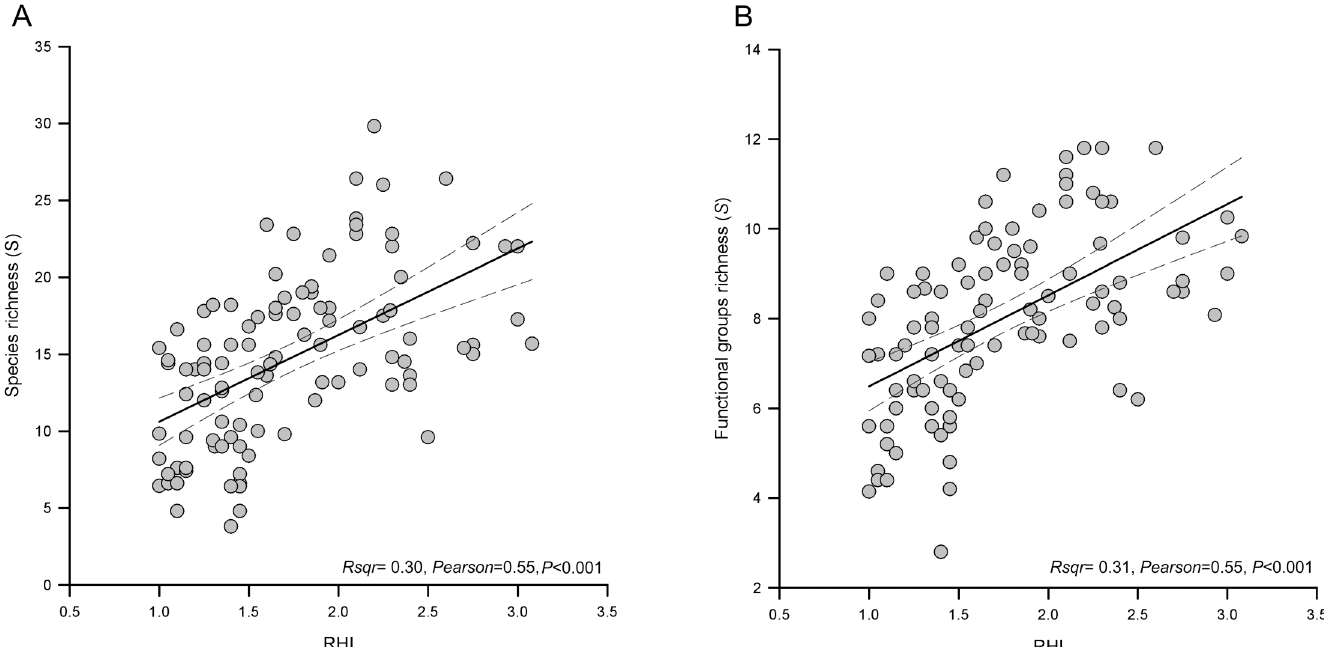
Fig 5. Linear regression and Pearson correlation. a) species richness of fish, b) richness of functional groups of fish in relation to the grades of coral health, according to the RHI at the scale of sites. Dotted lines indicate the 95% confidence interval.